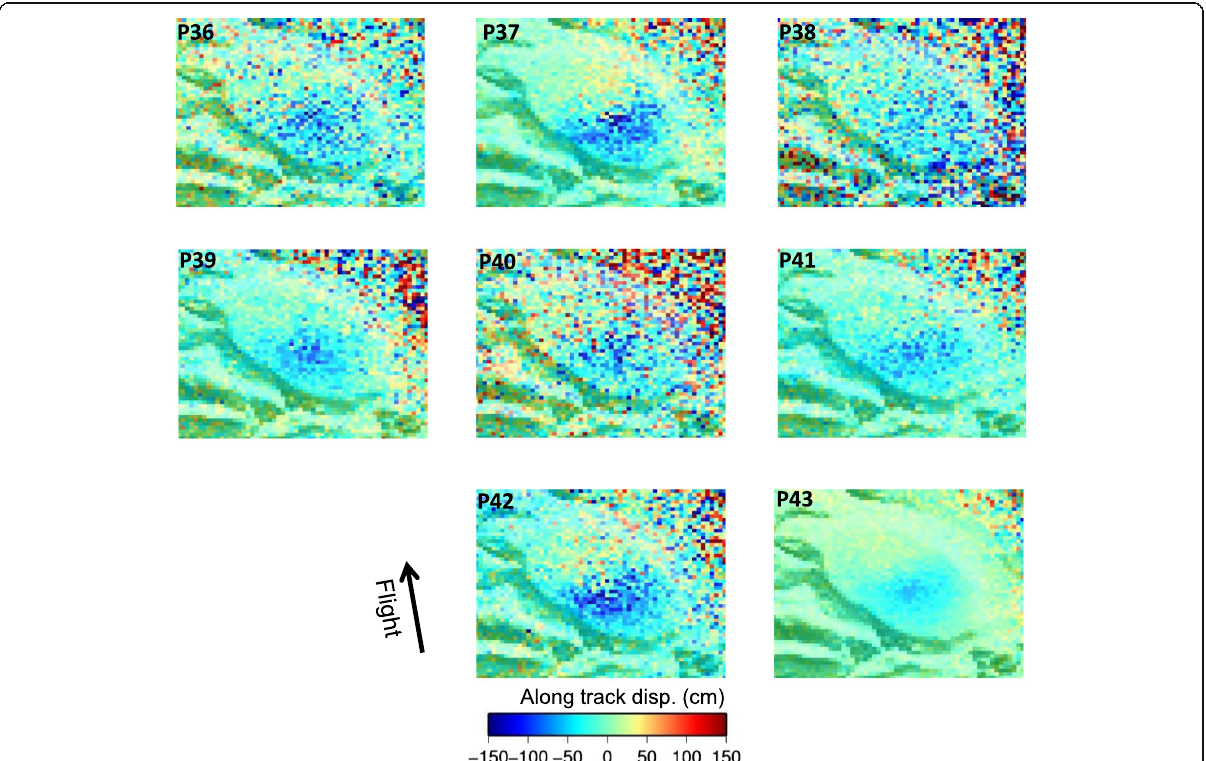
Fig. 7 Observed MAI data derived from ALOS/PALSAR ascending track data (path 573, frame 800). Positive and negative signals indicate the horizontal displacement projected in the direction of the satellite flight and the opposite direction, respectively. Details of each data set are described in Table